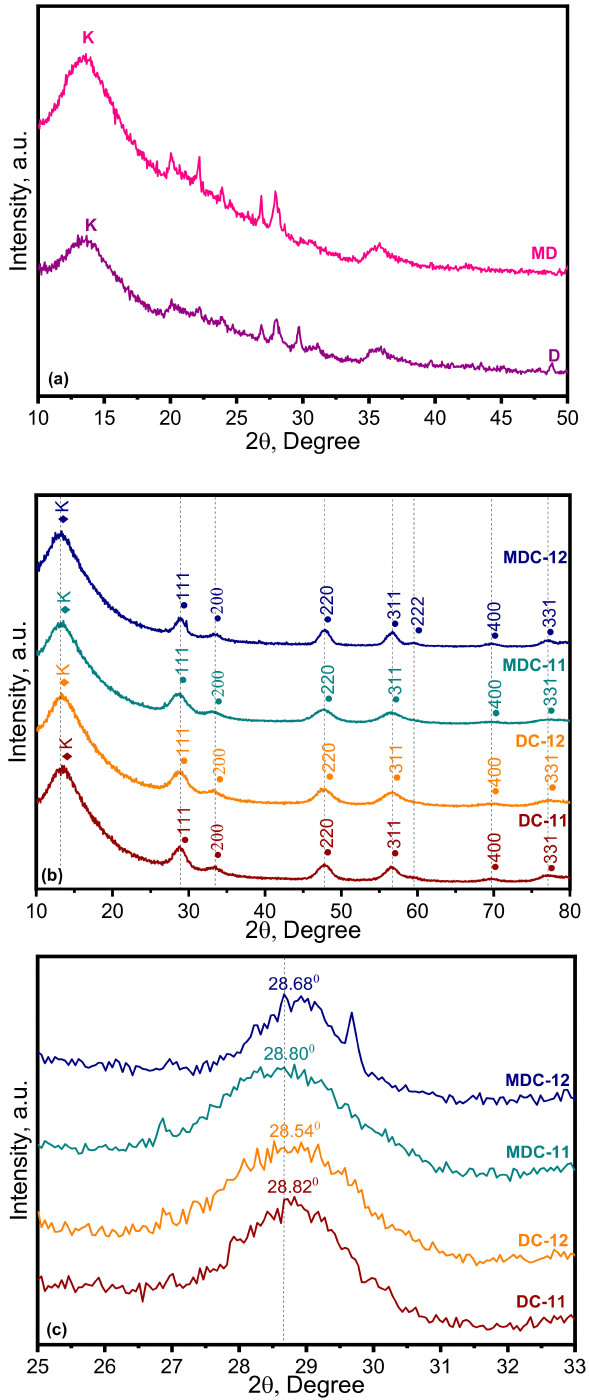
Figure 3. XRD spectra of ( a ) D, MD, ( b ) DC-11, DC-12, MDC-11, and MDC-12, ( c ) enlarged (111) plane of CeO 2